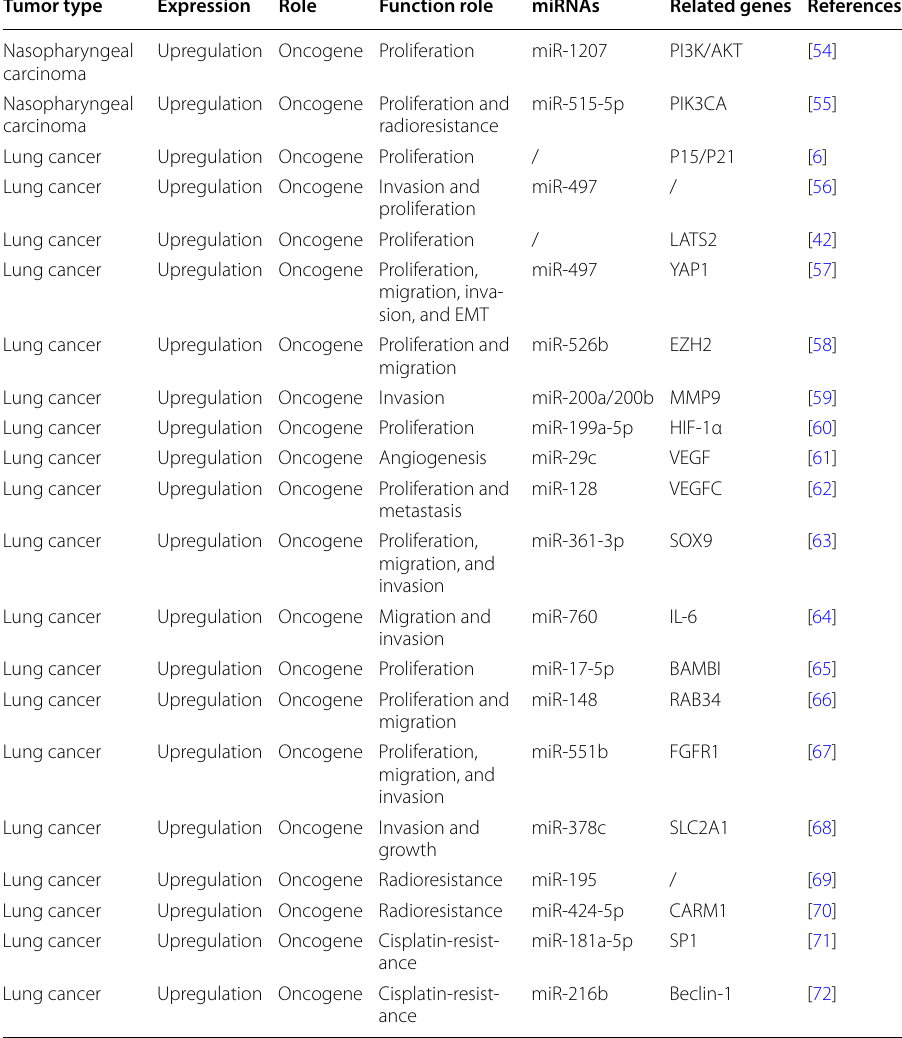
Table 1 Functional characterization of PVT1 in respiratory system tumors Tumor